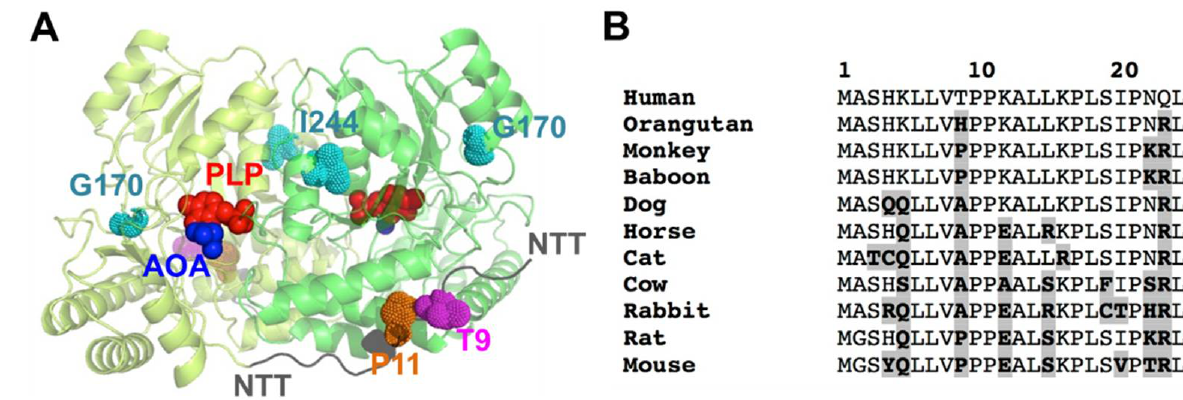
Figure 1. Structure of AGT and the location and conservation of T9 and P11 in the NTT. ( A ) Structural model of the AGT dimer, based on PDB 1H0C [34]. The figure shows the two monomers in the dimer (in two different green tones), the PLP and the inhibitor AOA (amino oxo-acetic acid) as red and blue spheres, respectively; the location of the NTT (in dark grey) with the residues T9 (pink) and P11 (orange) and the PH1 mutated residues in G170R and I244T (in cyan). ( B ) Evolutionary conservation of the 25 N-terminal amino acids of human AGT. Sequences are from mammalian ortologues. Residues in bold and highlighted in grey are those diverging from the human sequence. Note that T9 is only found in the human sequence, whereas P11 is strictly conserved.